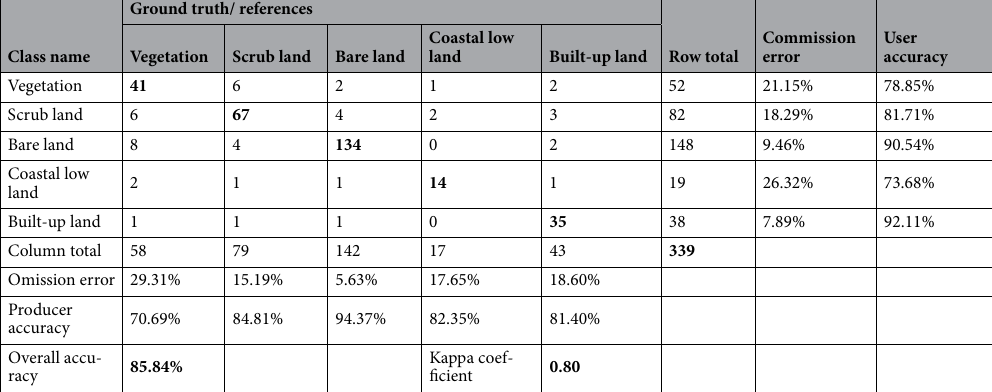
Table 7. Accuracy assessment and kappa coefficient for the year of 2010. The [bold] value is necessary to identify the accuracy assessment and kappa coefficient.